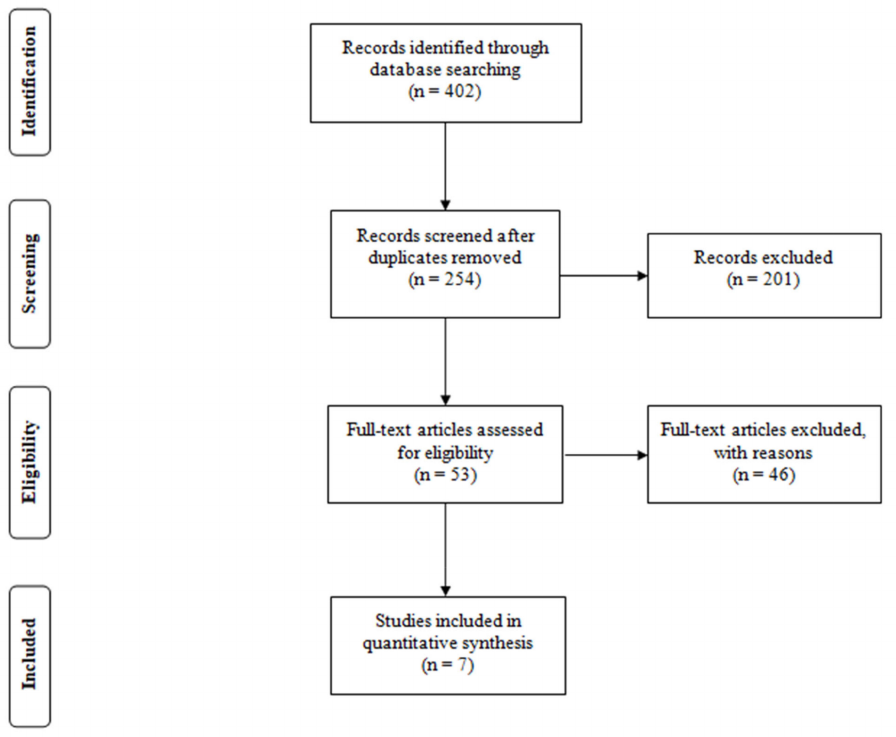
Figure 1. PRISMA flow